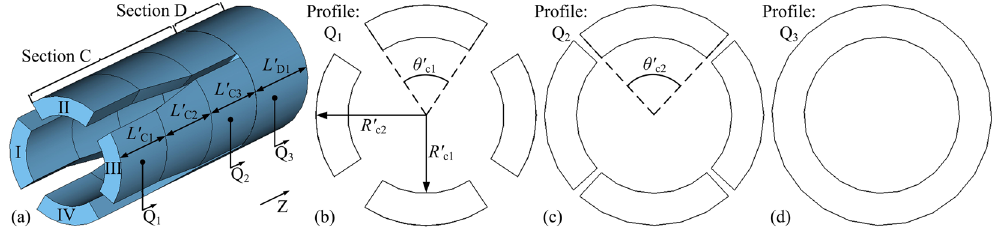
Figure 3. Schematic diagram of the ( a ) inner space of section C and D in an eight-cavity RM, and its transversal profiles in the ( b ) Q 1 plane, ( c ) Q 2 plane and ( d ) Q 3 plane.